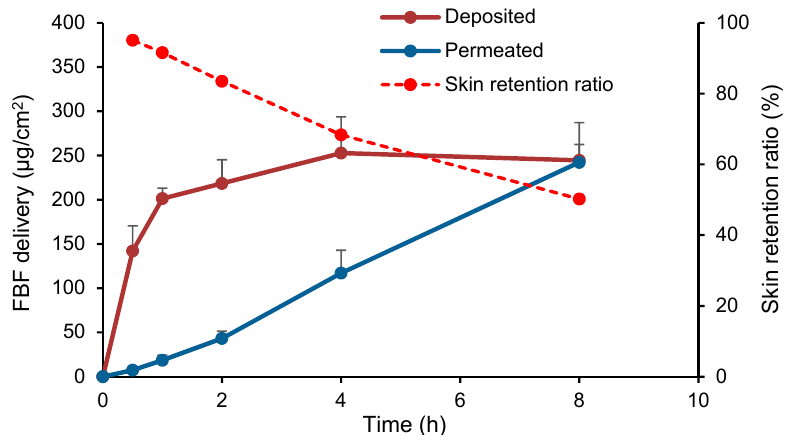
Figure 4. Effect of the duration of current application (0.5, 1, 2, 4, and 8 h) on FBF delivery and skin retention ratio after transdermal iontophoresis at 0.5 mA/cm2 using a 0.6% (w/w) HEC hydrogel. (Mean ± SD; n = 6).